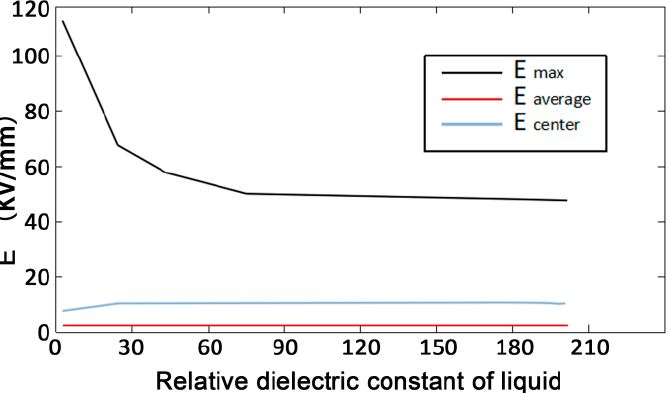
Figure 18. The variation of rock EFS with rock dielectric constant in different liquid media.